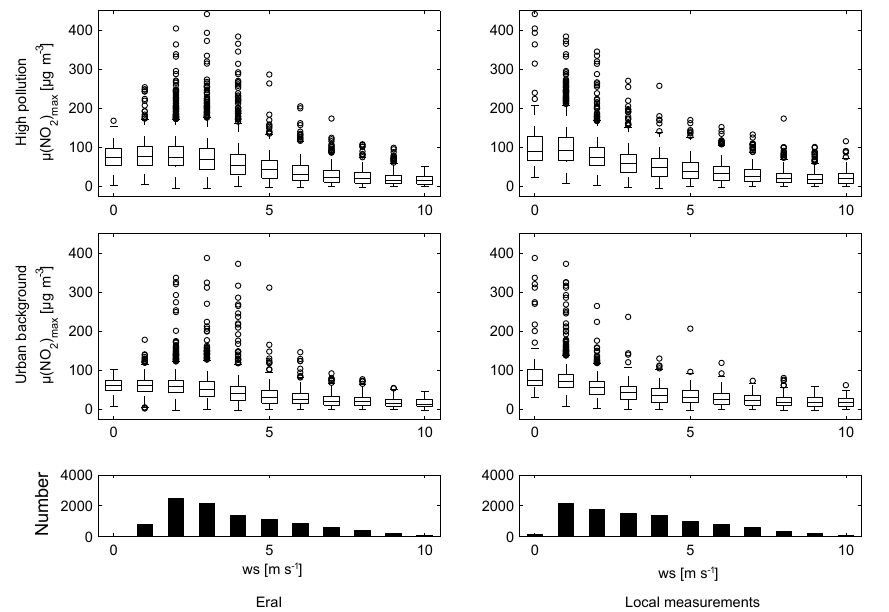
Figure 1. NO 2 concentrations at the two air quality reference stations in Bergen against the 10m wind speeds (ws) over the Bergen Valley from EraI and from local measurements inside the valley between 2003 and 2013. EraI data are available every 3h. NO 2 concentrations and the local measured winds represent hourly means. The NO 2 concentrations are the 3-hourly maxima and the local wind data are the 3-hourly means around the 3h time steps. Only wintertime data (November–February) are included. The edges of the boxes are the 25th and 75th percentiles. Lines inside the boxes show the median. The maximum whisker length is 1.5 times the distance between the 25th and 75th percentiles or the maxima and minima of the data. Outliers with higher or lower concentration values than that are shown as circles. The lower panels show the number of simultaneously valid wind and pollution measurements within each wind-speed